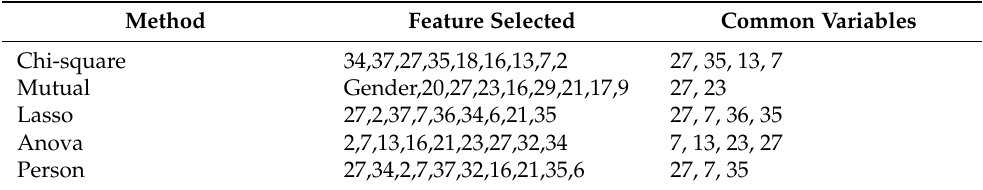
Table 4. Summary of Feature Selection